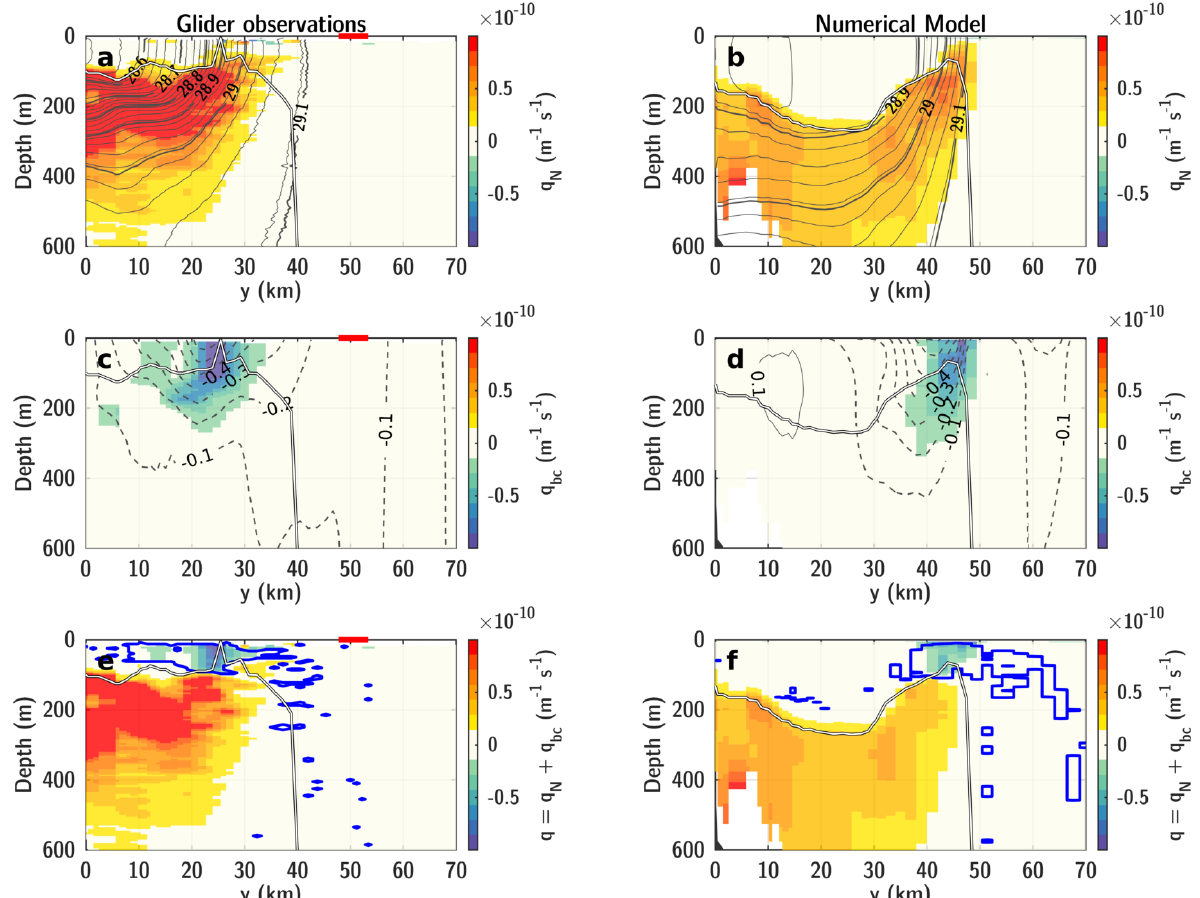
Figure 6. PV decomposition for the glider transect of the right column in Figure 5: ( a ) stratification term q N with isopycnal contours in black and ( c ) baroclinic term q bc term with contours of geostrophic velocities. MLD is shown by the white line. ( e ) Section of geostrophic PV ( q = q N + q bc ). The blue contours represent areas prone to symmetric instability. The red lines show where the angle between DAC and glider track exceed 45 ◦ . ( b , d , f ) same as ( a , c , d ) but evaluated in the numerical